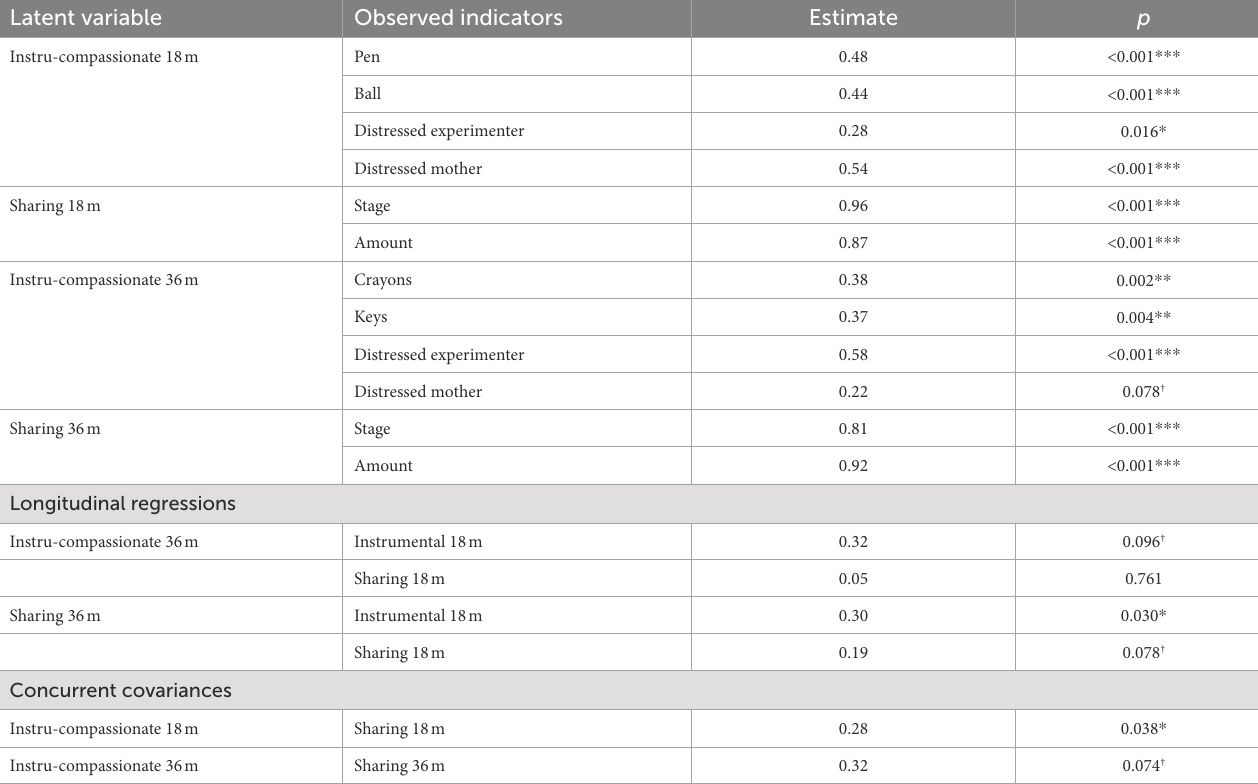
TABLE 5 Standardized parameter estimates from final SEM